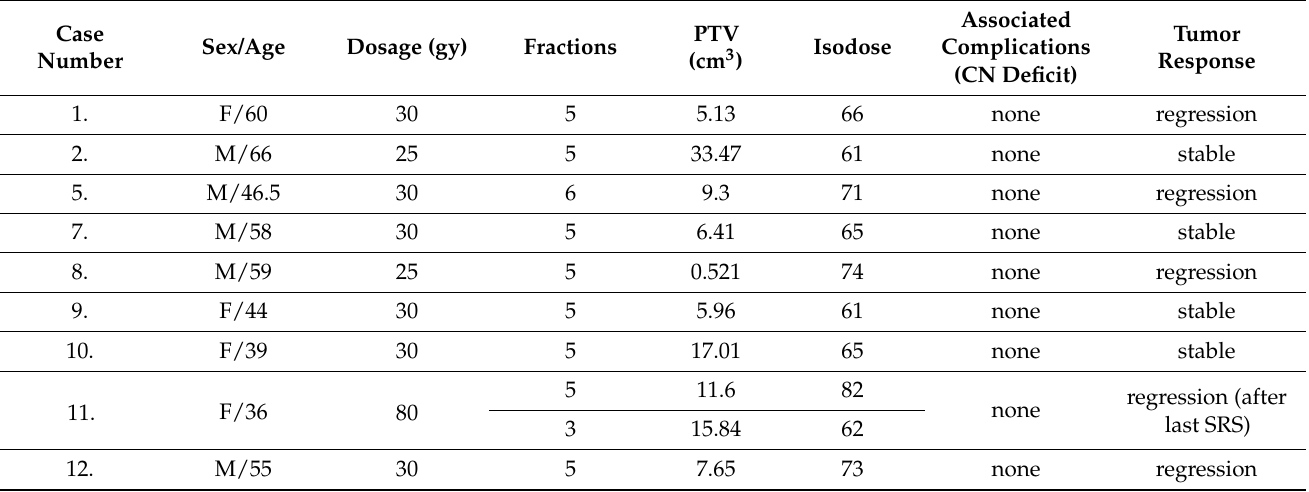
Table 2. CyberKnife radiosurgery—treatment parameters and patient outcome.